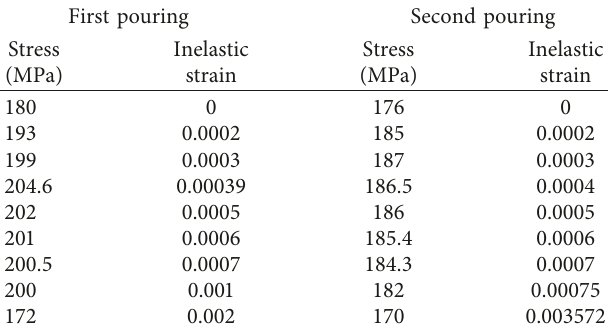
Figure 13: (a) Plastic model. (b) Damaged plastic model. Table 8: Average compressive inelastic stress-strain test results for Table 9: Parameters for modeling tension the UHPC.